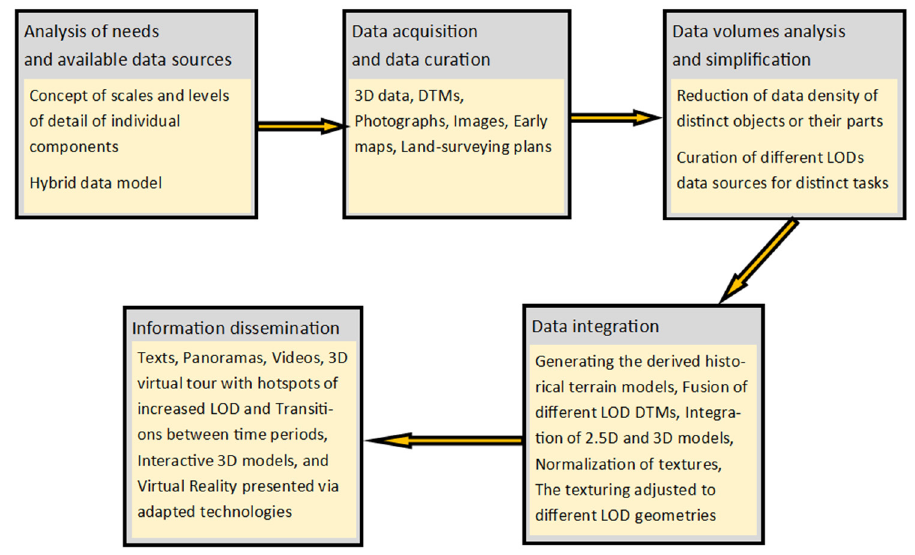
Figure 2. The solution’s workflow summary starting with the conceptual analysis to the employment of technology for distribution of variable thematic data layers.